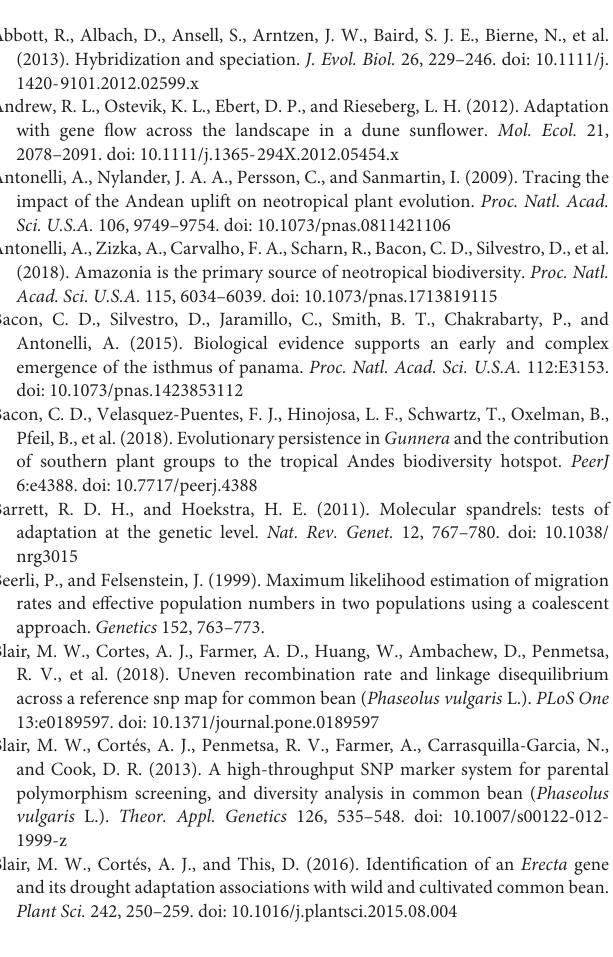
random effect. The gray dashed horizontal lines mark the P -value thresholds after Bonferroni-correction for multiple comparisons. FIGURE S5 | Networks depicting bidirectional gene flow patterns leading to panmixia (N e m > 1) among populations of Espeletia . The width of the green lines is proportional to the number of migrants per generation (N e m) and are shown only if N e m > 1. First row of diagrams are based on the entire set of populations (A–D) , whereas second and third rows only include contrasting populations for localities (E–G) and for habitats (H–K) , respectively. First column of diagrams are based on the entire SNP dataset (A,E,H) , while second, third and fourth columns only include markers significantly associated with the localities (B,F,I) , the theoretical exposure to frost (C,G,J) and the theoretical soil moisture content (D,K) , respectively. The dataset that only includes contrasting populations for localities and markers significantly associated with the theoretical soil moisture content is not shown because lack of polymorphism (one variable site). Allelic associations were quantified as described in the legend of Figure 5 . Maximum N e m values are shown within parenthesis in the upper left corner. Localities are identified by different colors. Populations’ names within nodes are given by the combination of codes for localities and ecotypes, colored and coded as in Figure 1 . FIGURE S6 | Correlations between genetic differentiation, geographic distance and ecological distance (exposure to frost and soil moisture content) among populations of Espeletia growing in 3 different habitats and 6 localities. First column of diagrams show F ST /(1 – F ST ) vs. geographic distance (i) , following Rousset (1997), while second and third columns show F ST /(1 – F ST ) vs. ecological distances based on theoretical (as coded in Supplementary Table S1 ) exposure to frost (ii) and soil moisture content (iii) , respectively. First four rows of diagrams